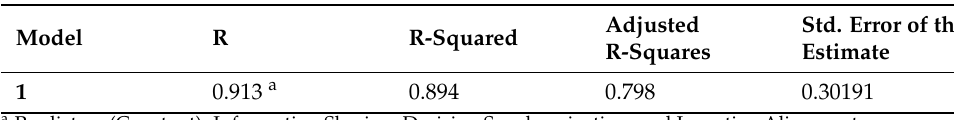
Table 5. Model summary.